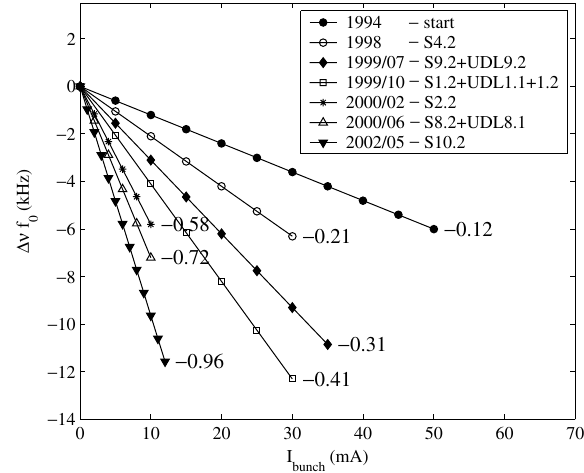
FIG. 6. Vertical coherent tune shift evolution.